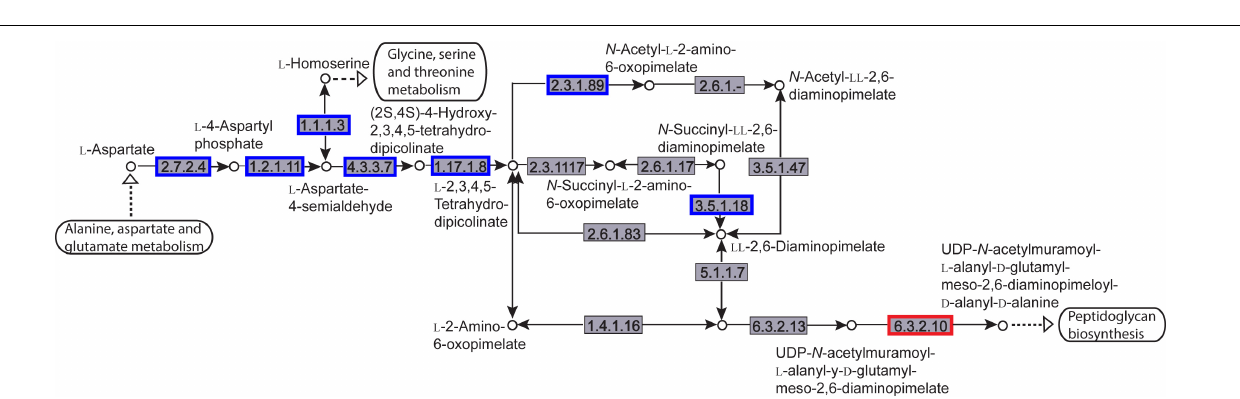
FIGURE 11 | Distribution of the differentially expressed genes (DEGs) in a peptidoglycan biosynthesis pathway. Compared with the control group, an enzyme with a blue frame is related to a downregulated gene, an enzyme with a red frame is related to an upregulated gene. The number within the frames represents the enzyme